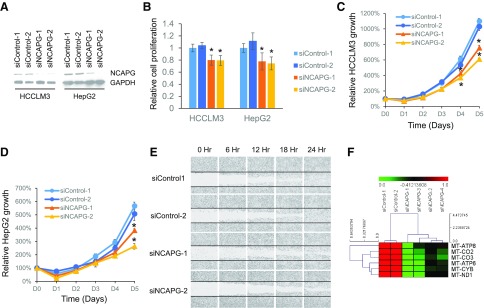
Transient knockdown of NCAPG inhibits cell growth, migration, and mitochondrial gene expression. A) Western blot showing the successful knockdown of NCAPG in HCCLM3 and HepG2 cells transfected with siRNAs targeting NCAPG (siNCAPG-1 and -2) compared with either control siRNAs (siControl-1 and -2). with glyceraldehyde-3-phosphate dehydrogenase (GAPDH) as endogenous control. B) Relative cell proliferation measured using MTS assay showing significantly reduced cell proliferation potential in cells transfected with siRNAs targeting NCAPG compared with control cells. C, D) Relative cell growth showing significantly slower cell growth in NCAPG knockdown HCCLM3 (C) and HepG2 (D) cells vs. control, measured using cell counting with Trypan blue exclusion assay. E) Wound healing assay showing reduced cell migration in NCAPG knockdown cells compared with control cells. Horizontal lines mark the margins of the initial wound. F) Heat map showing significant down-regulation of mitochondrial genes in the electron transport chain in NCAP knockdown cells compared with control cells. CO, cytochrome C oxidase; CYB, cytochrome B; MT, mitochondrially encoded; ND1, NADH:ubiquinone oxidoreductase core subunit 1.